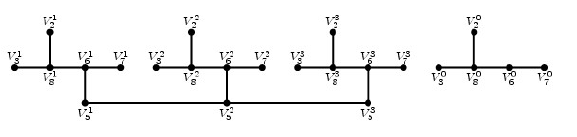
Figure 6. Subgraph of ][ 4 24 24